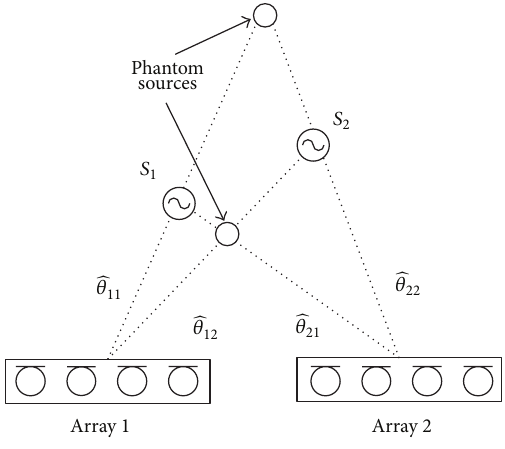
Figure 1: The problem of multiple sources localization.